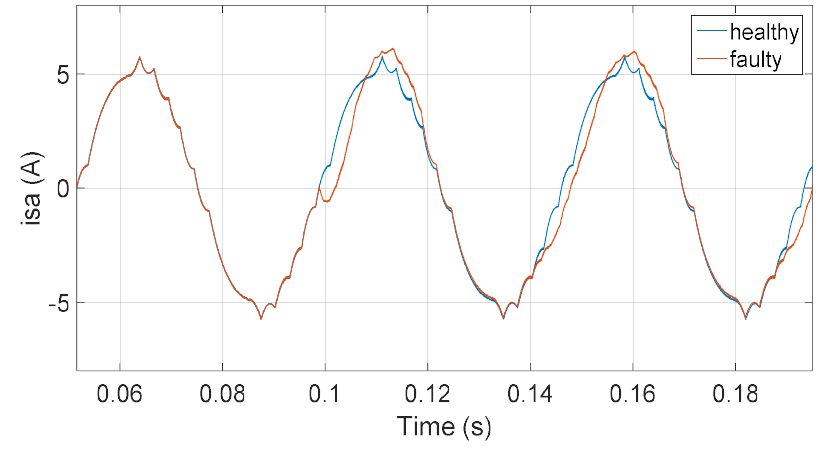
Figure 3. Phase current with a permanent OSF.